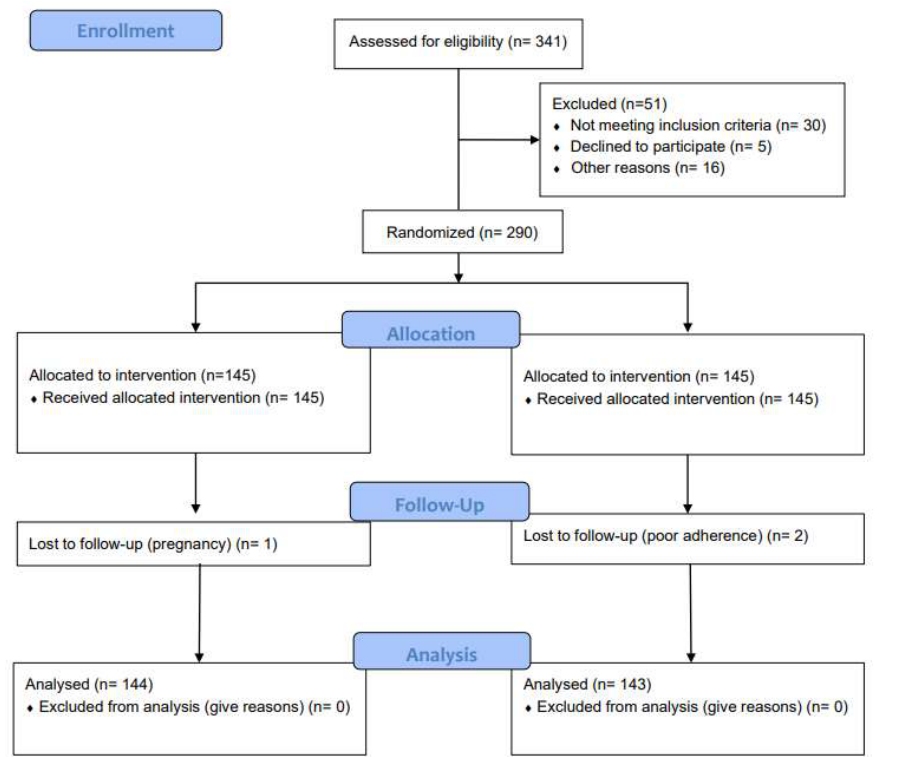
Figure 2. The study flow-chart.